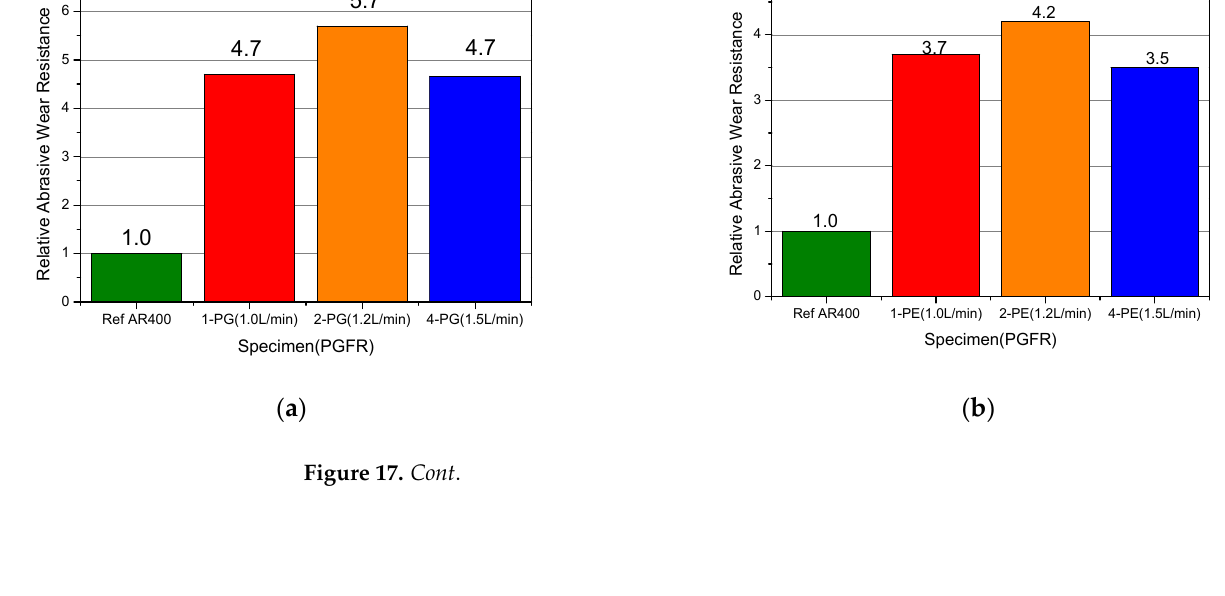
( d ) Figure 17. Comparative plots on the effects of PGFR on abrasive wear performance and hardness of surface coatings ( a , b ) effects of PGFR on the abrasive wear resistance of samples prepared with PG and PE powder MMCs, respectively ( c , d ) effects of PGFR on hardness of matrix of samples prepared with PG and PE powder MMCs, respectively. The optimum process parameters from those listed in Table 2, coupled with PPTAW device working parameters are summarized in Table 10. These parameters were used extensively for the study, and they formed the basis for the presented results. Table 10. Optimum process parameters used for sample preparation, applicable to the two MMC powders used for this study. Process Parameter